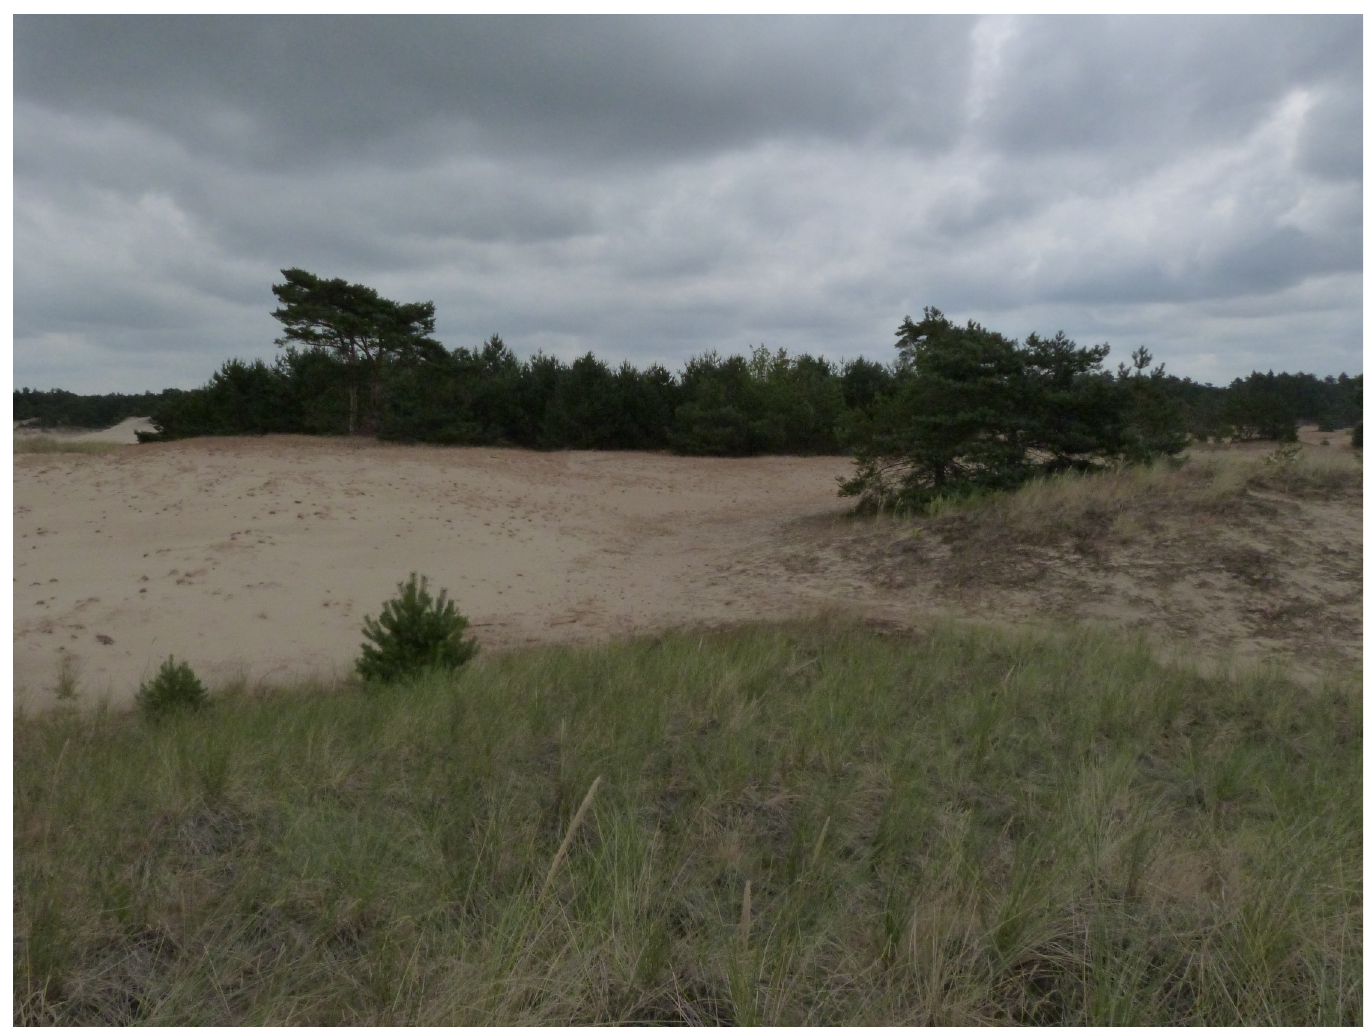
Fig 2. Different successional stages at the youngest plot A in 2015. Photo by K.